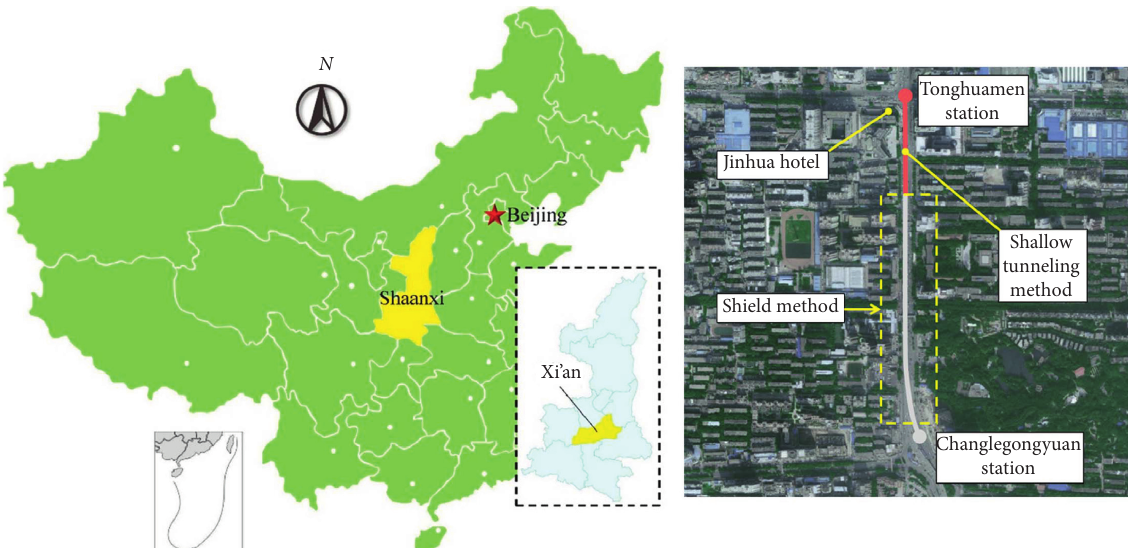
Figure 1: Location of the metro project (images by